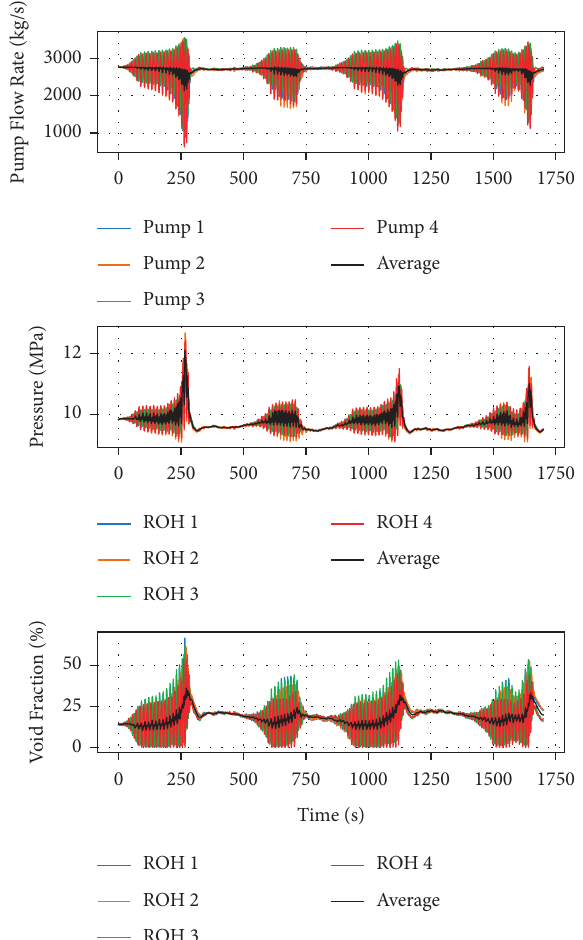
Figure 23: Flow rate oscillations at 108% full power with blocked header interconnects—full simulation. The even pair of pumps and headers oscillate out-of-phase with the odd